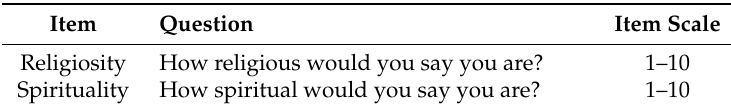
Table 3. Operationalization of religiosity and spirituality.